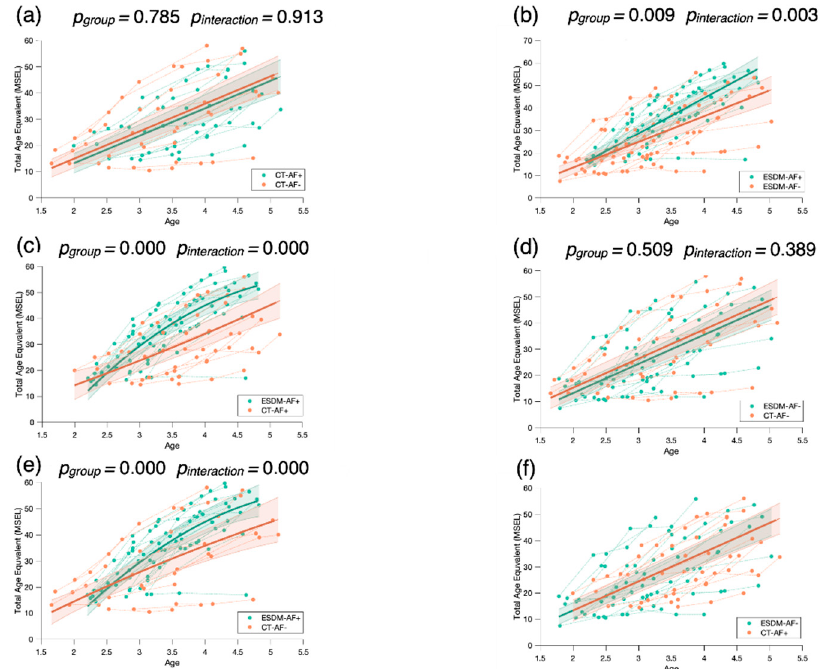
Figure A2. Mixed model post hoc analysis for the MSEL Total Age Equivalent comparing the four groups of children two by two: the two groups of children receiving community treatment with a different level of attention to face at baseline ( CT-AF+ ; CT-AF- ) ( a ), the two groups of children receiving an early and intensive intervention with a different level of attention to face at baseline ( ESDM-AF+ ; ESDM-AF- ) ( b ), the two groups of children with more attention to face at baseline ( ESDM-AF+ ; CT-AF+ ) ( c ), the two groups of children with less attention to face at baseline ( ESDM- AF- ; CT-AF- ) ( d ), the group receiving an early and intensive intervention with more attention to face at baseline ( ESDM-AF+ ) and the group of children receiving community treatment with less attention to face at baseline ( CT-AF- ) ( e ), and the group receiving the early and intensive intervention with less attention to face at baseline ( ESDM-AF- ) and the group of children receiving community treatment with more attention to face at baseline ( CT-AF+ ) ( f ). The group-level trajectory (bold line) is derived from mixed-effect modeling [43–45]. The 95% confidence interval is indicated by the colored bands around the estimated group-level